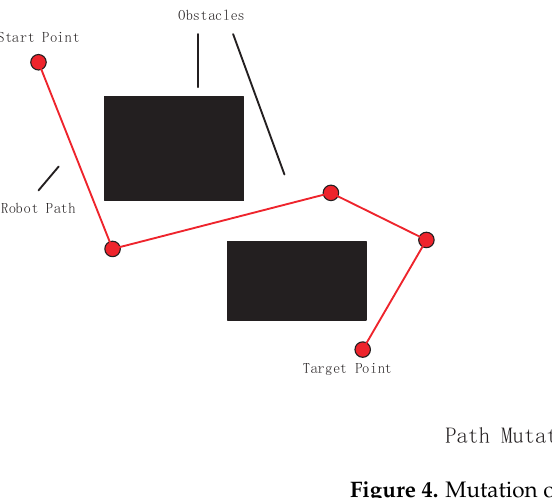
Figure 4. Mutation